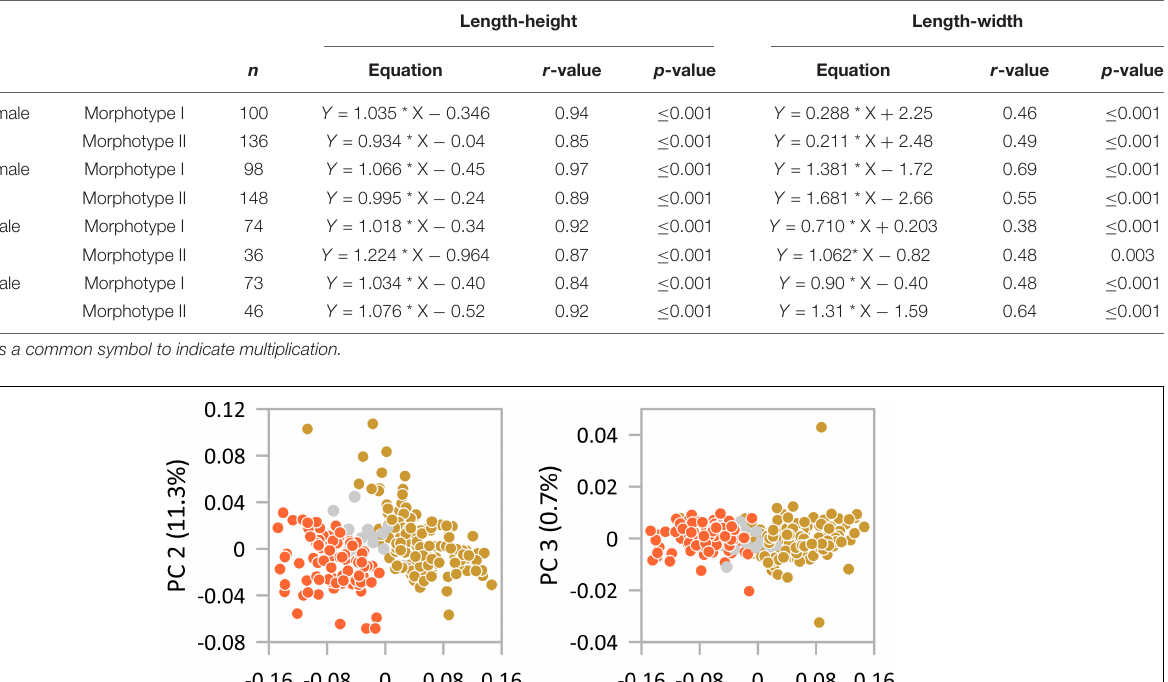
TABLE 3 | Differences of length-height regression coefficients and slopes of both Cyprideis morphotypes indicated for both sexes and left (LV) and right (RV) valves.